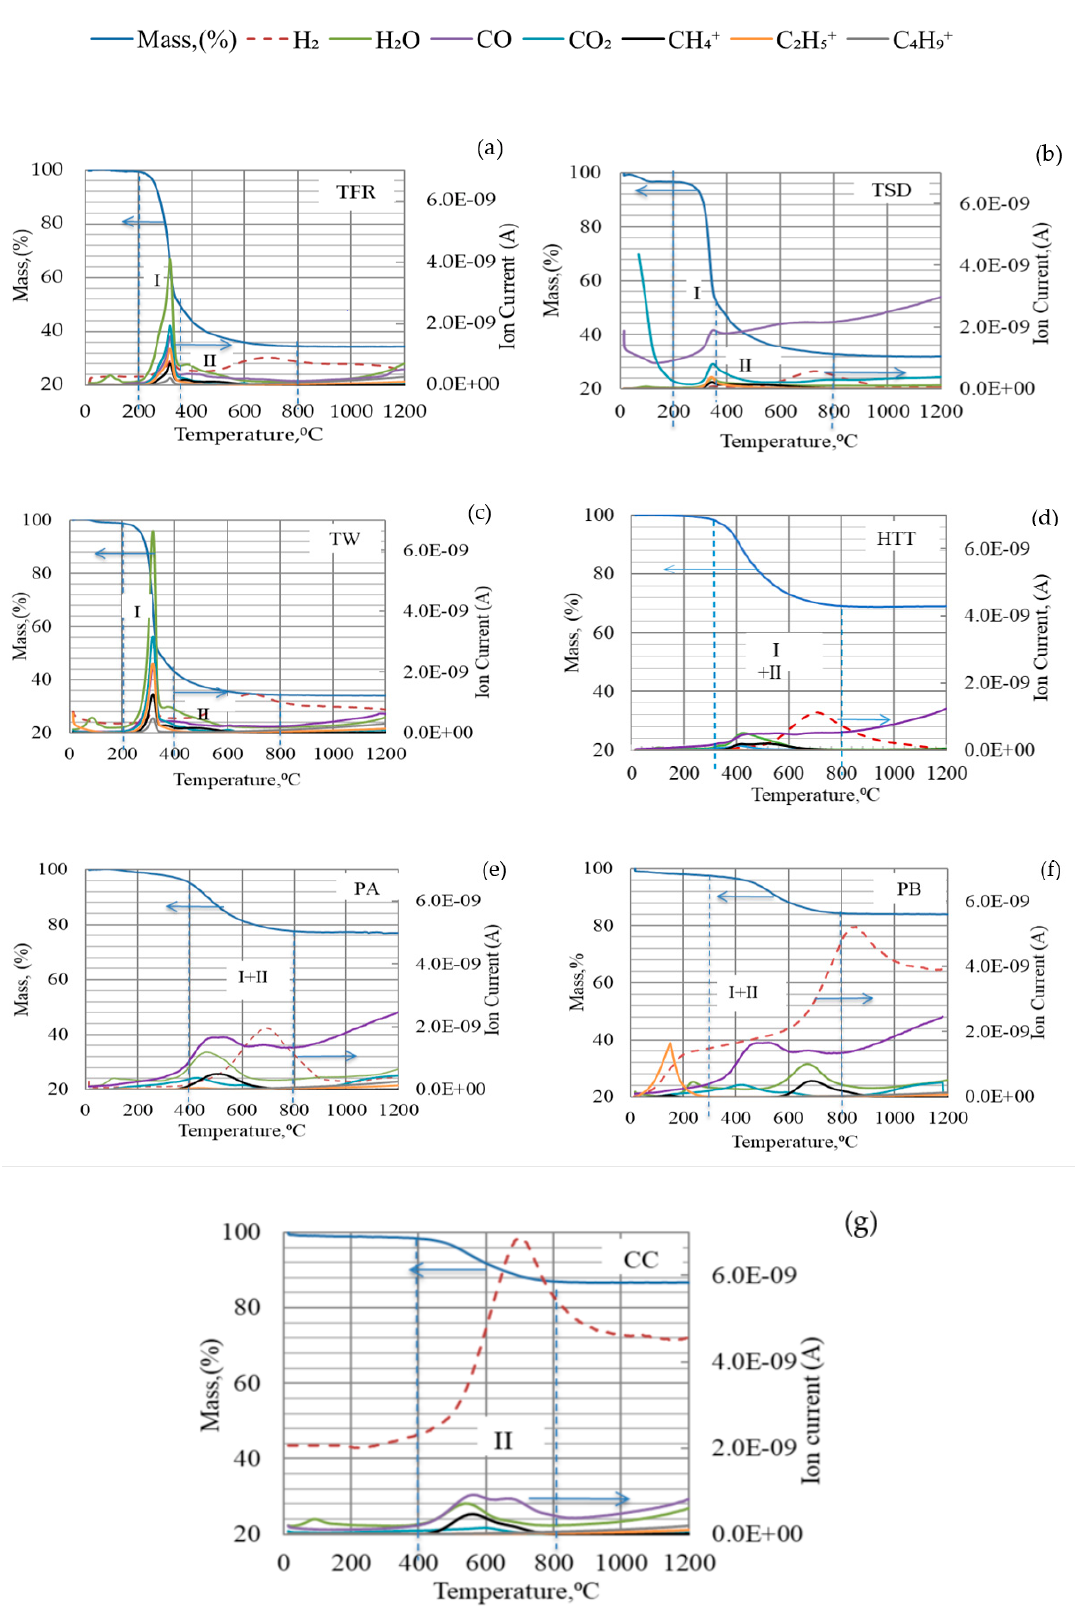
Figure 3. TGA–QMS analysis of different types of bio-coals: ( a ) TFR; ( b ) TSD; ( c ) TW; ( d ) HTT; ( e ) PA; ( f ) PB; ( g ) CC in Argon at a heating rate of 5 °C /min up to 1200 °C.